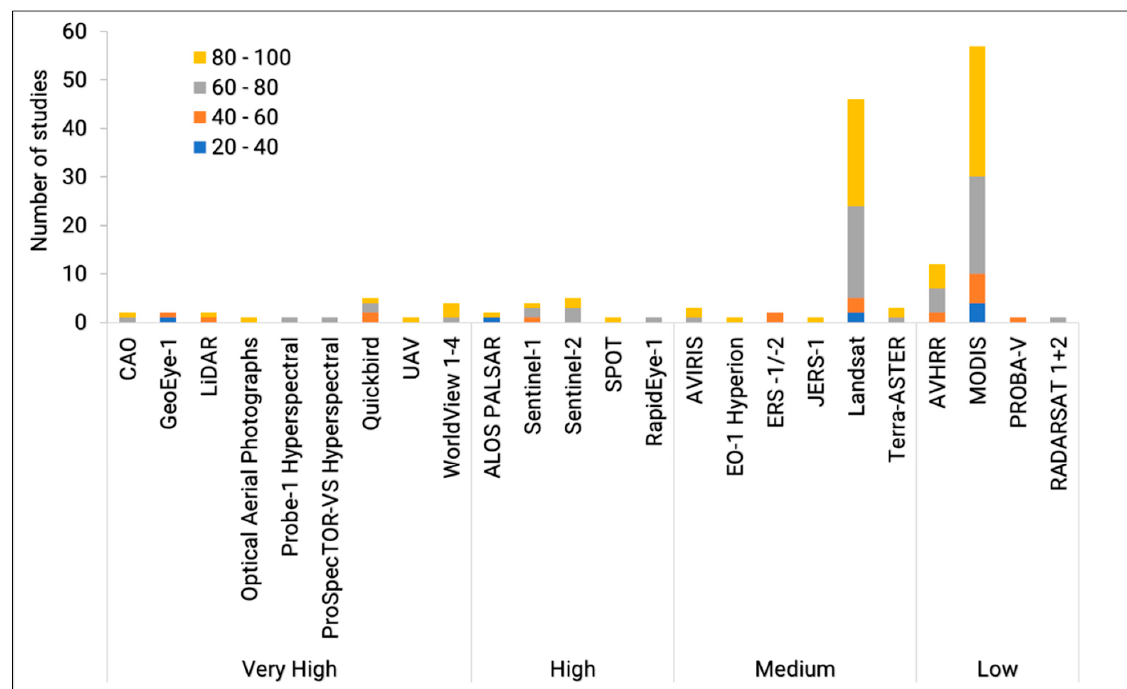
Figure 13. Overview of the employed EO datasets for mixed pixel analysis and their accuracies. The EO datasets are grouped according to their spatial resolution. The graph analysis only incorporated EO datasets from the 159 studies which reported an overall accuracy.